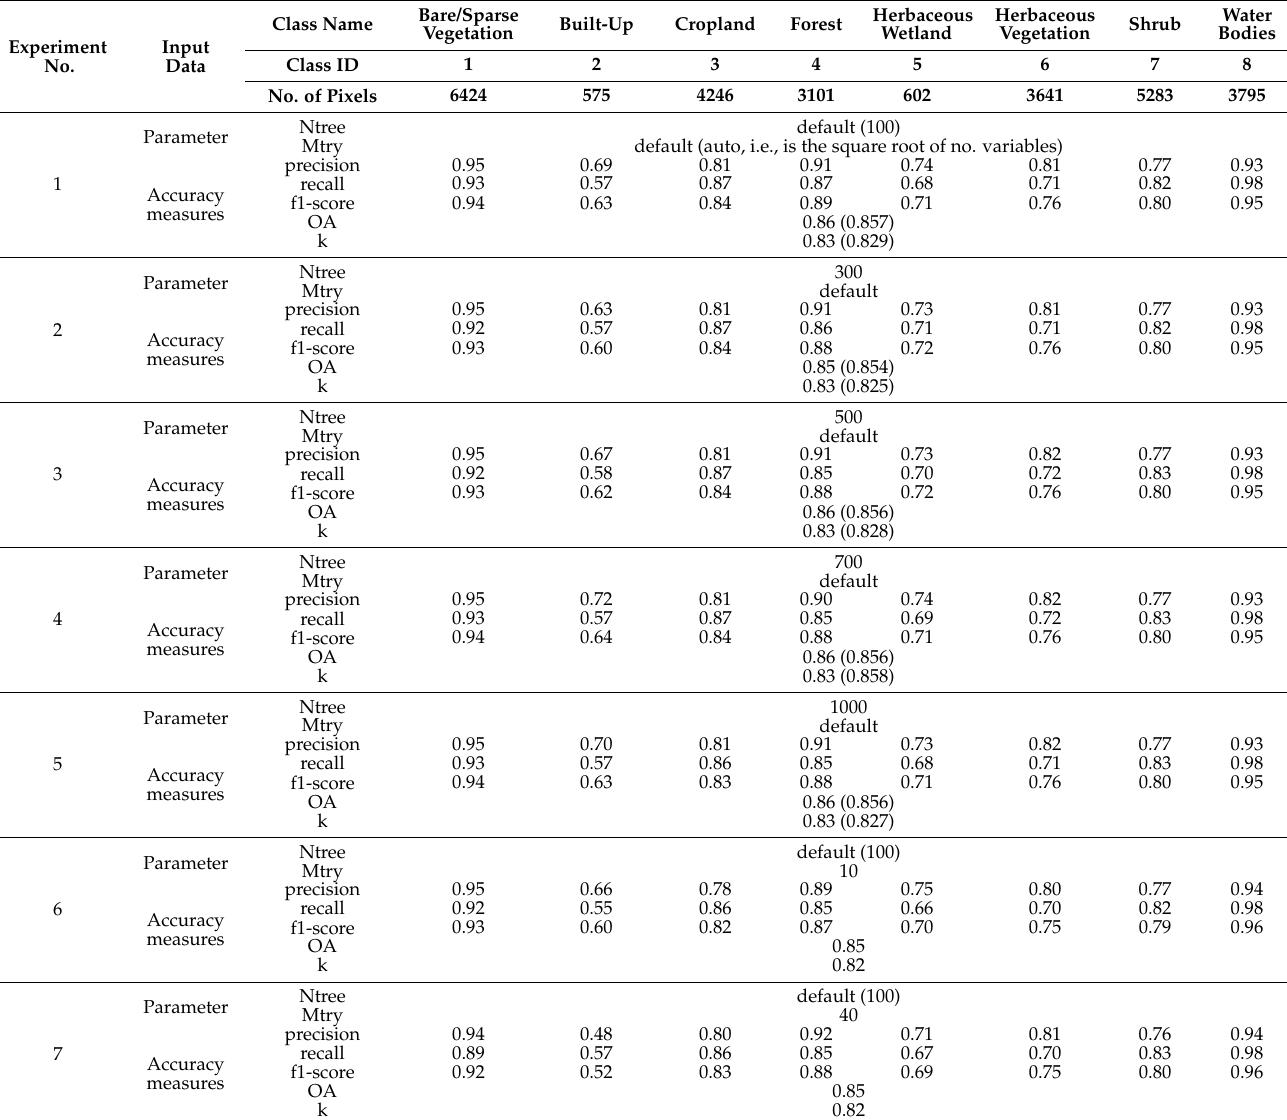
Table 4. Accuracy of the various RF